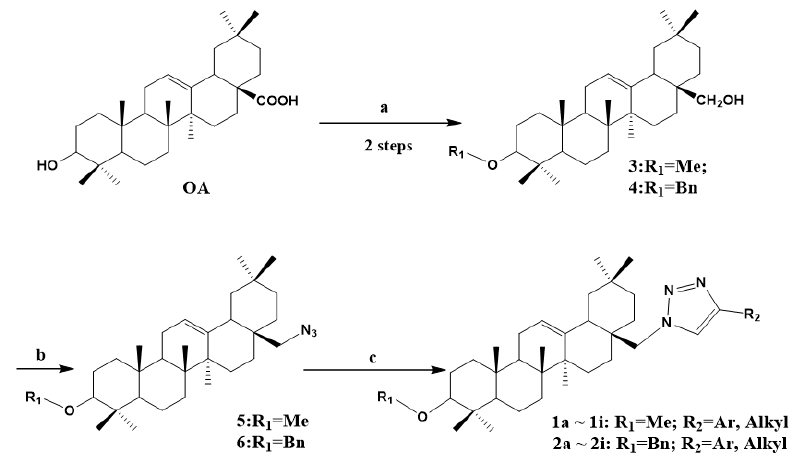
Scheme 1. Synthesis of the target compounds 1 and 2 . Reagents and conditions: step a: (1) MeI/